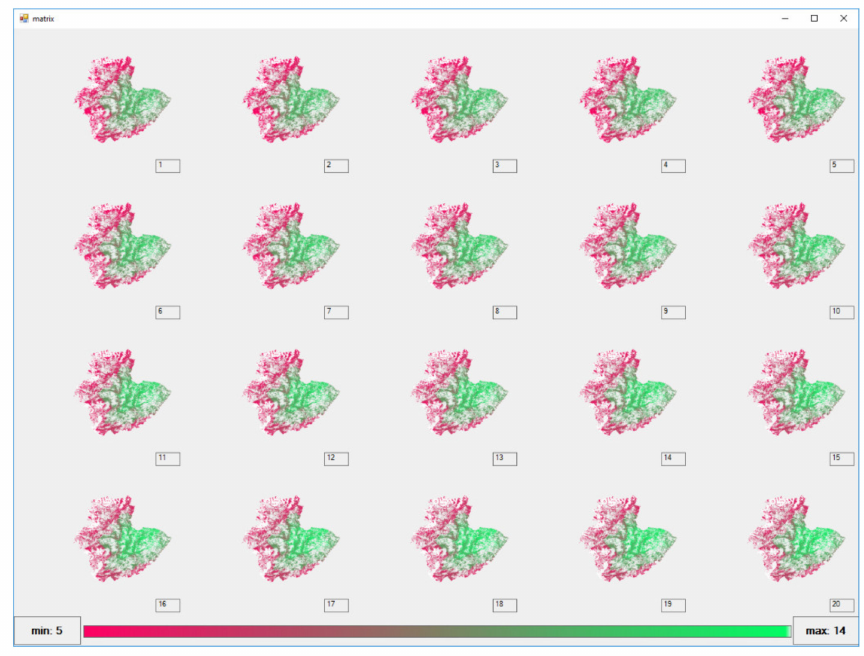
Figure A8. Price distribution for Scenario 1 (Biomass III (B 3 ), thinning) over a period of 20 years (t 1 to t 20 ) in the Nordeste region, Portugal. The minimum price was 5 € / m 3 (light red) and the maximum 14 € / m 3 (light